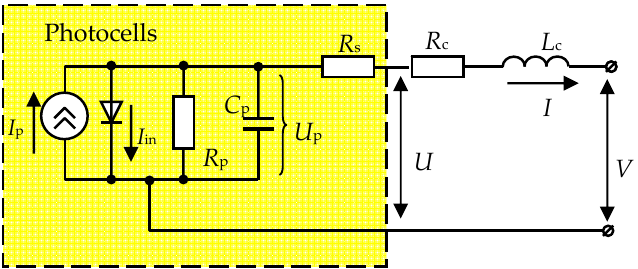
Figure 2. Equivalent circuit of a solar cell photocell, taking into account reactive components.